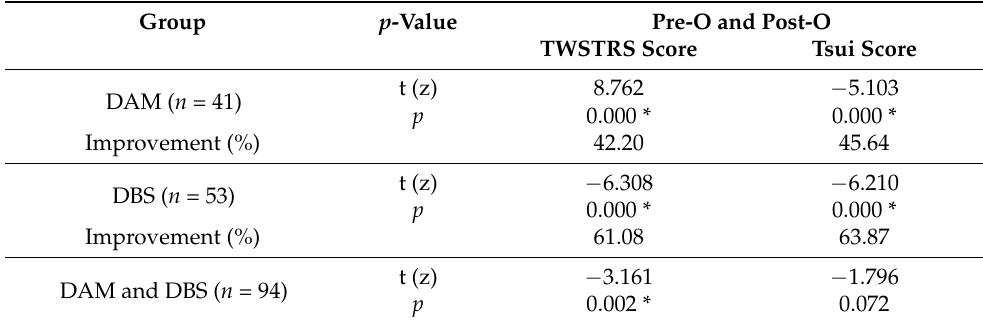
Table 3. Statistical analysis of improvement in TWSTRS and Tsui scores in the DAM group and DBS group.